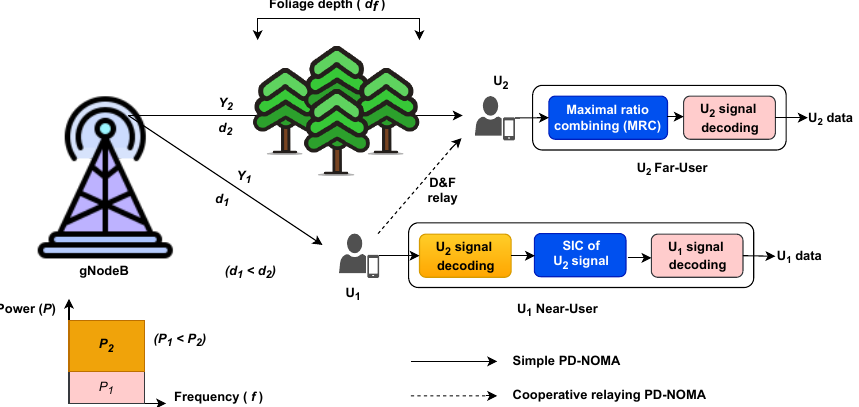
Figure 8. SISO cooperative relaying PD-NOMA model (U 1 is used as a